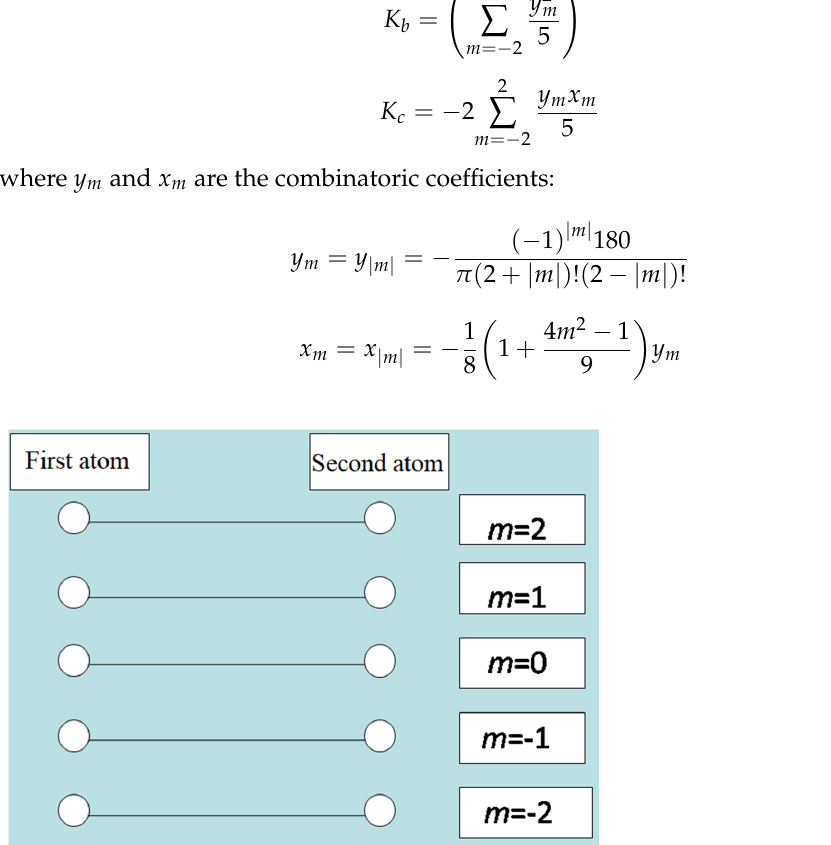
Figure 1. Five d-d -electron couplings diagonal with respect to m between two atoms.